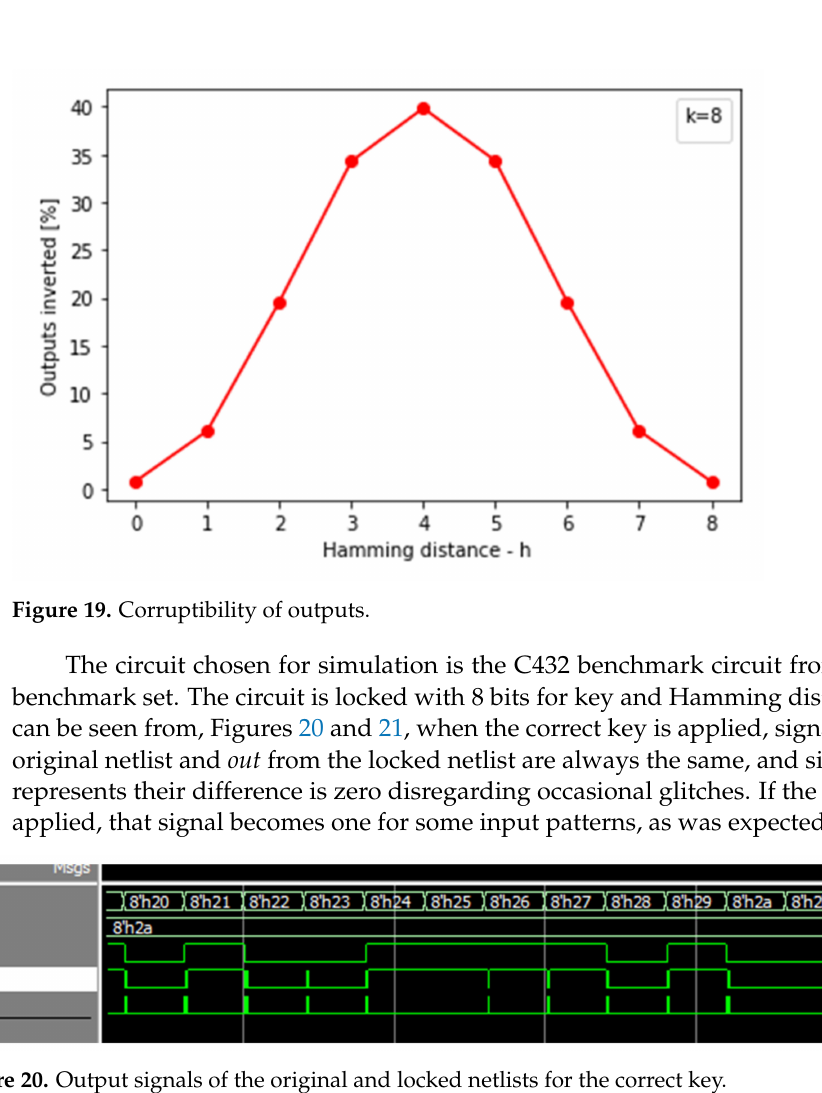
Figure 20. Output signals of the original and locked netlists for the correct key.